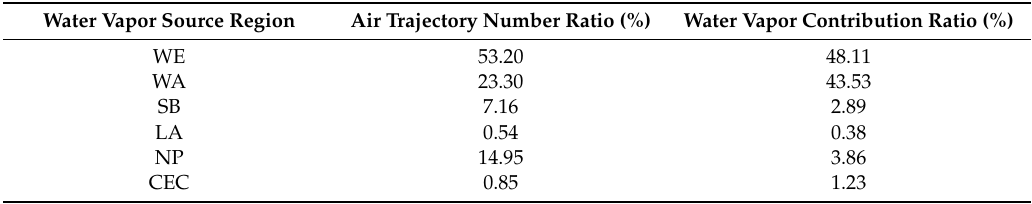
Table 3. Total air trajectories and total water vapor contributions of snow season in six water vapor source regions from 1980 to 2017.